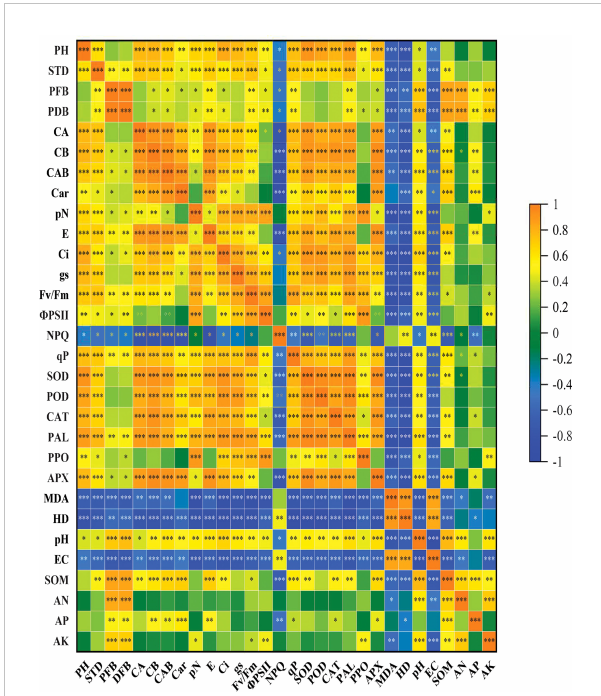
FIGURE 1 Pearson correlation between eggplant growth, physiological and soil chemical parameters. The brown color represents a positive correlation while the blue color represents a negative correlation. The lighter colors indicate the lower values of the correlation coef fi cient, while darker colors indicate high positive correlation. PH, Plant height; STD, stem diameter; PFB, plant fresh weight; PDB, plant dry biomass; CA, chlorophyll a; CB, chlorophyll b; CAB, chlorophyll ab; Car, carotenoids; pN, net photosynthesis; E, transpiration rate; Ci, internal CO 2 rate; gs, stomatal conductance; Fv/Fm, photochemical ef fi ciency; Ф PSII, photosystem II; NPQ, non- photochemical quenching coef fi cient; qP, photochemical quenching; SOD, super oxidase; POD, peroxidase; PAL, phenylalanine ammonia – lyase; PPO, polyphenol oxidase; APX, ascorbate peroxidase; CAT, catalase; MDA, malonaldehyde; HD, hydrogen peroxide; EC, electrical conductivity; AP, available phosphorus; AK, available potassium; SOM, soil organic matter The stars indicate a signi fi cant correlation at (*) 0.05, (**) 0.01, (***), and 0.001 levels of signi fi